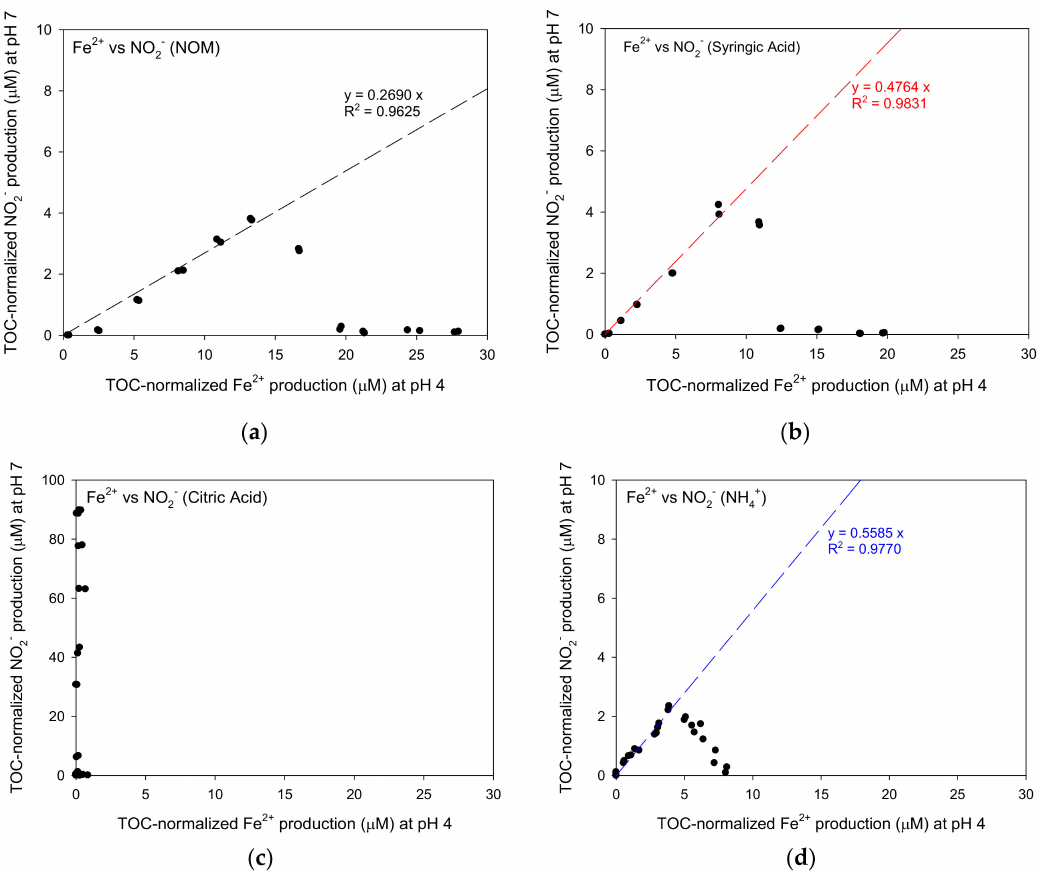
Figure9. TherelationshipbetweenTOC-basedFe 2 + concentrationsatapHof4andNO 2 − concentrations at a pH of 7: ( a ) NOM, ( b ) syringic acid, ( c ) citric acid and ( d )